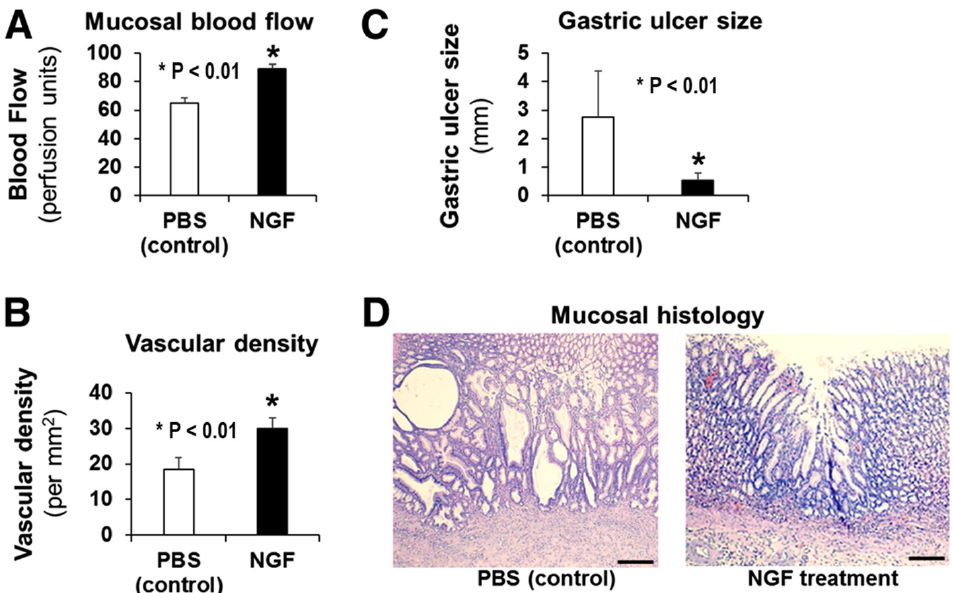
Figure 10. Local NGF therapy of GUs in aging rats increases angiogenesis, accelerates gastric ulcer healing, and improves the quality of mucosal regeneration. In aging rats, either PBS (control) or NGF (100 µ g/kg body weight in 200 µ L PBS) was locally injected to the ulcer base after GU induction. Mucosal blood flow, microvessel density, GU size, and mucosal regeneration were examined 3 weeks after GU induction. Local NGF treatment of GUs in aging rats ( A ) significantly increased mucosal blood flow in GU scars/margins by 37% compared to the control, and ( B ) increased vascular density in granulation tissue at the base of the GU scar/margin by 62% compared to the control, both showing increased angiogenesis. ( C ) NGF therapy accelerated GU healing, as reflected by the >5-fold reduction in GU size. ( D ) Mucosal histology showed better regeneration of gastric mucosa in GU scars of NGF-treated rats compared to the poor, disorganized, and abnormal regeneration (e.g., large, dilated, irregular abnormal glands) in the control group (reprinted with permission from [96]).